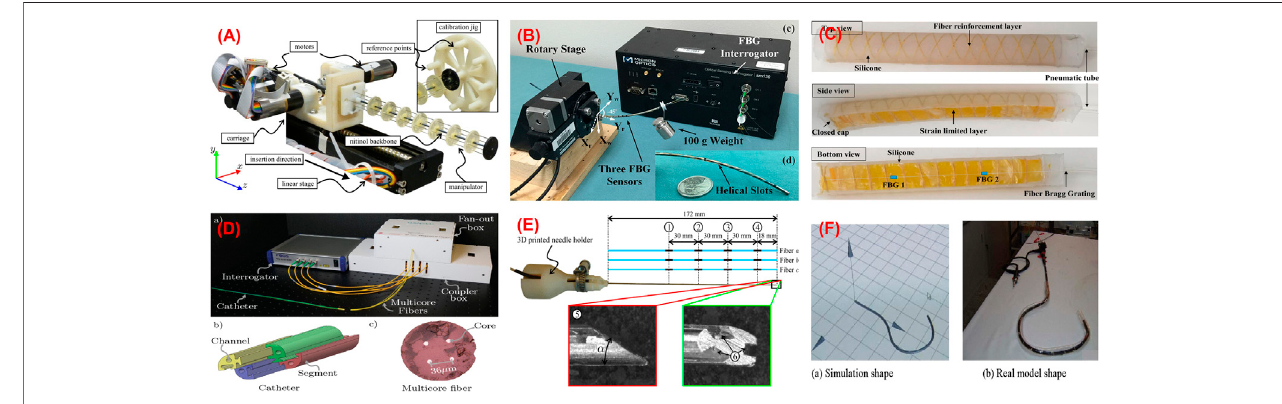
FIGURE 3 | Shape sensing using FBG. (A) Tenon driven manipulator (Roesthuis et al., 2013); (B) pre-curved nitinol tube (Xu et al., 2016); (C) soft manipulator (He et al., 2018); (D) catheter (Khan et al., 2019); (E) needle (Roesthuis et al., 2014); (F) colonoscope (Yi et al., 2007).